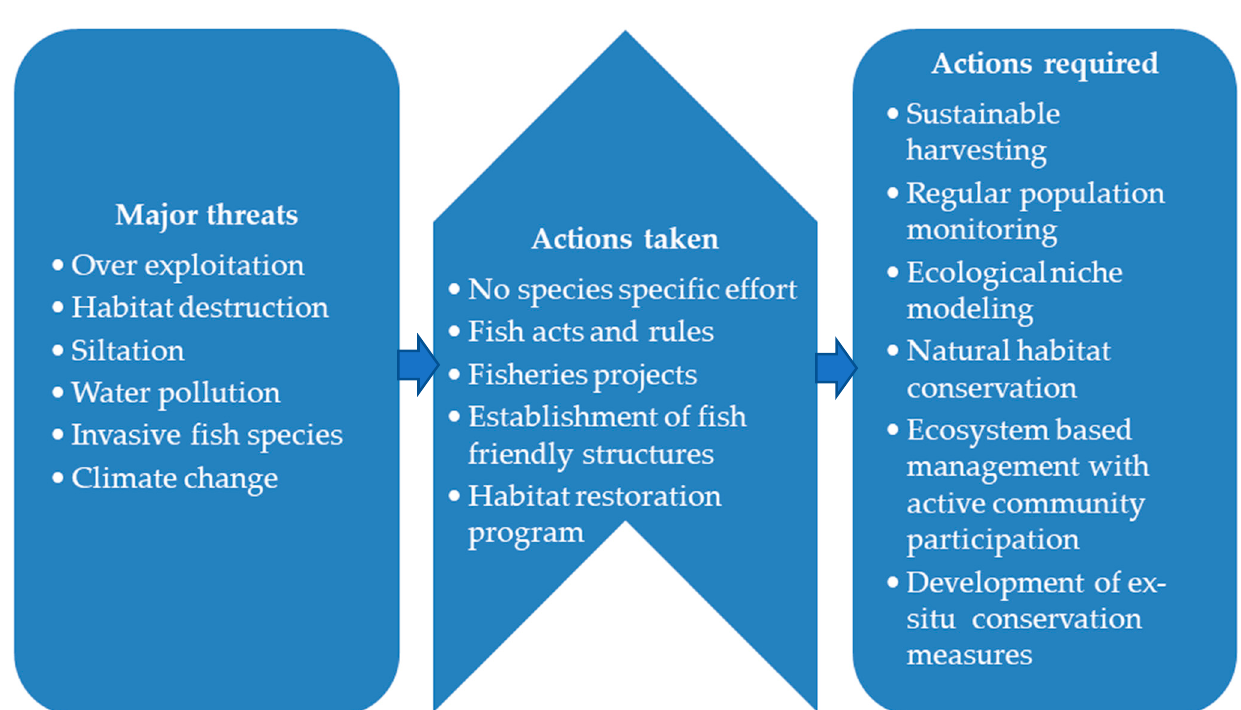
Figure 5. A schematic diagram depicting the major threats, actions taken, and actions required for B. bagarius conservation in the inland waters of Bangladesh.